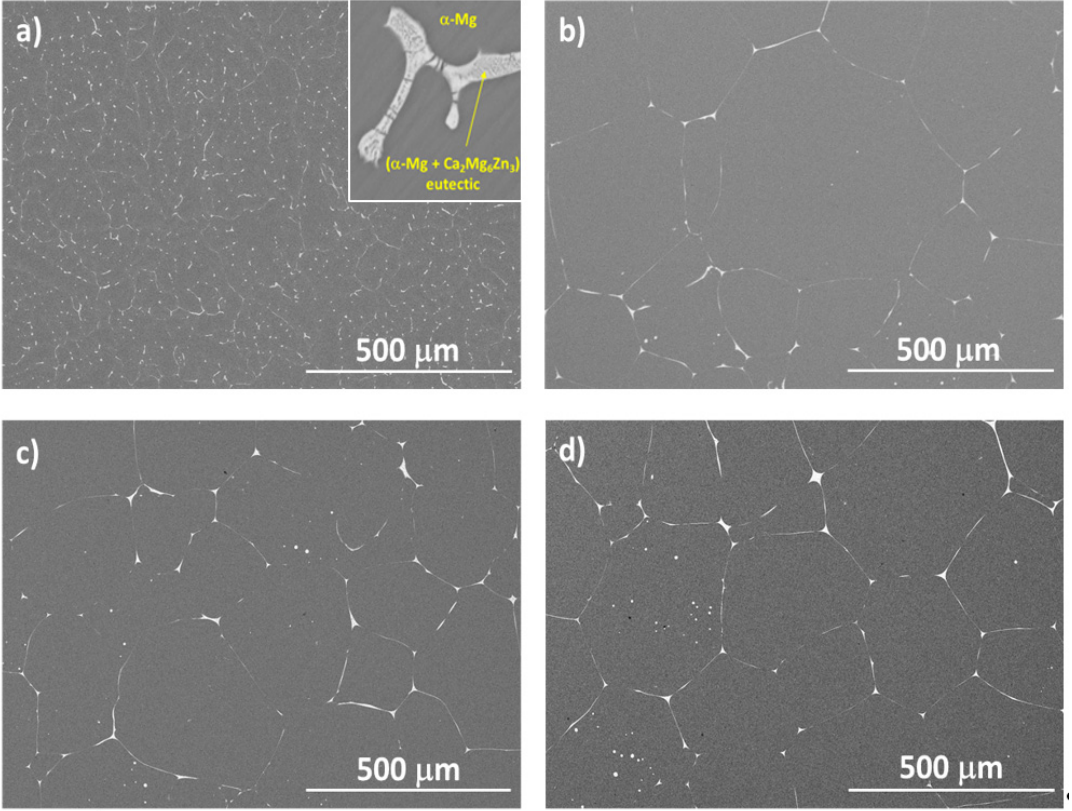
Figure 1. SEM micrographs of the ZX30 alloy samples: ( a ) as-cast, ( b ) solution-treated, ( c ) peak-aged, and ( d ) over-aged.